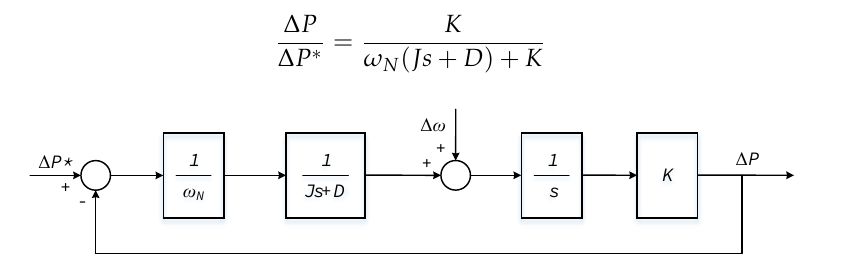
Figure 8. Small signal model of active power of the VSG controller.